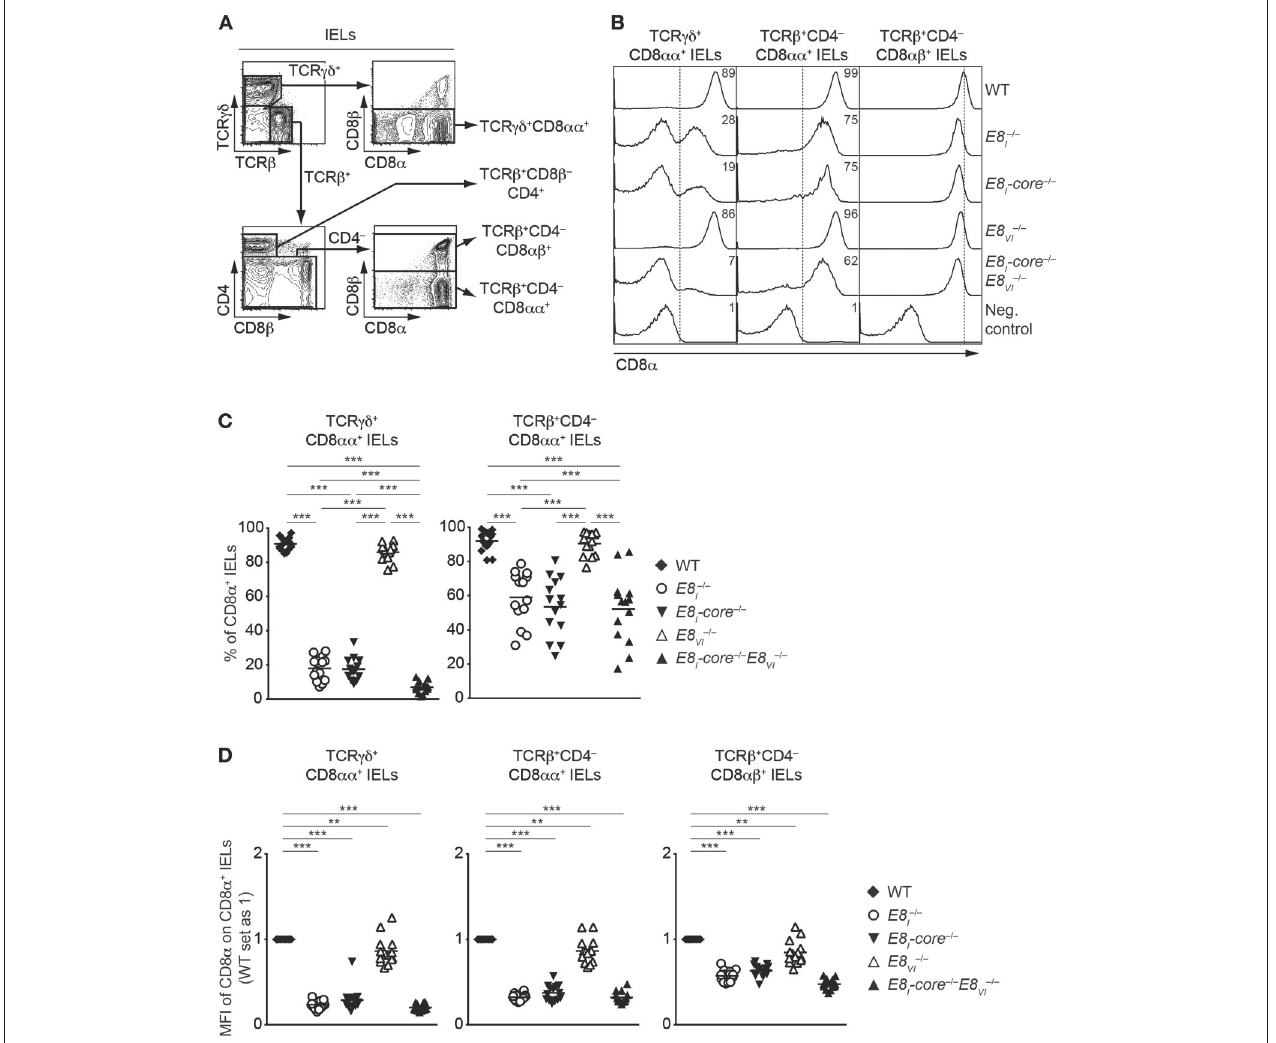
FIGURE 6 | CD8 αα expression on IELs is predominantly regulated by E8 I -core . (A) Representative gating strategy for the analysis of CD8 α expression on TCR γδ + CD8 αα + , TCR β + CD8 β − CD4 + , TCR β CD4 − CD8 αα + , TCR β + CD4 − CD8 αβ + , and IELs. (B) Histograms showing CD8 α expression on TCR γδ + CD8 αα + , TCR β + CD4 − CD8 αα + , and TCR β + CD4 − CD8 αβ + IELs isolated from wild-type (WT), E8 I − / − , E8 I - core − / − , E8 VI − / − and E8 I - core − / − E8 VI − / − mice. CD8 α expression on WT CD19 + B cells is shown as a negative staining control. Dotted lines indicate either gating region for the CD8 α + population (TCR γδ + CD8 αα + and TCR β + CD4 − CD8 αα + IELs) or the peak of CD8 α expression on WT cells (TCR β + CD4 − CD8 αβ + IELs). Numbers indicate the percentages of CD8 α + cells. (C) Diagrams showing the percentage of CD8 α + cells within TCR γδ + CD8 αα + , and TCR β + CD4 − CD8 αα + IELs isolated from wild-type (WT), E8 I − / − , E8 I - core − / − , E8 VI − / − and E8 I - core − / − E8 VI − / − mice. Data obtained from the analysis of WT, E8 I − / − , E8 I - core − / − TCR γδ + CD8 αα + IELs (as shown in Figure 2D , left panel) were included in the corresponding diagram. Each dot represents one mouse. Horizontal bars indicate mean values. A one-way ANOVA analysis followed by Tukey’s multiple-comparison test was performed for statistical analysis. (D) Diagrams showing the relative mean fluorescence intensity (MFI) of CD8 α expression within the CD8 α + population of TCR γδ + CD8 αα + , TCR β + CD4 − CD8 αα + , and TCR β + CD4 − CD8 αβ + IELs isolated from wild type (WT), E8 I − / − , E8 I - core − / − , E8 VI − / − and E8 I - core − / − E8 VI − / − mice. The MFI values of WT cells are set as 1. Data obtained from the analysis of WT, E8 I − / − , E8 I -core − / − TCR γδ + CD8 αα + IELs (shown in Figure 2D , right panel) were included in the corresponding diagrams. Each dot represents one mouse. Horizontal bars indicate mean values. A one-sample t -test was performed for statistical analysis, where the values obtained from each group of the mutant mice were compared to the WT ones (i.e., 1). (C,D) The p -values were defined as following: **, p < 0.01; ***, p < 0.001. Data are representative (B) or show the summary (C,D) of 14–17 mice (B,C,D) analyzed in 16 (B,C,D) independent